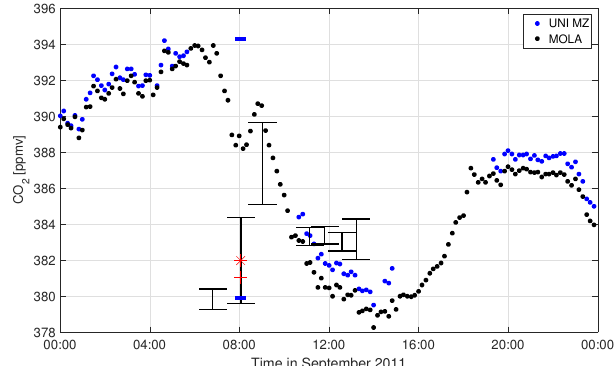
Figure 14. CO 2 surface measurements (on Mount Kleiner Feld- berg (825ma . s . l . ), see Sect. 2.2), including the aircraft observa- tions (mean and standard deviation between 1000 to 1600ma.s.l.) on 6 September 2011. The high CO 2 fluctuations at 08:00UTC are demonstrated by the mean (red star), standard deviation (black error bars), median (red bar) and maximum/minimum values (blue